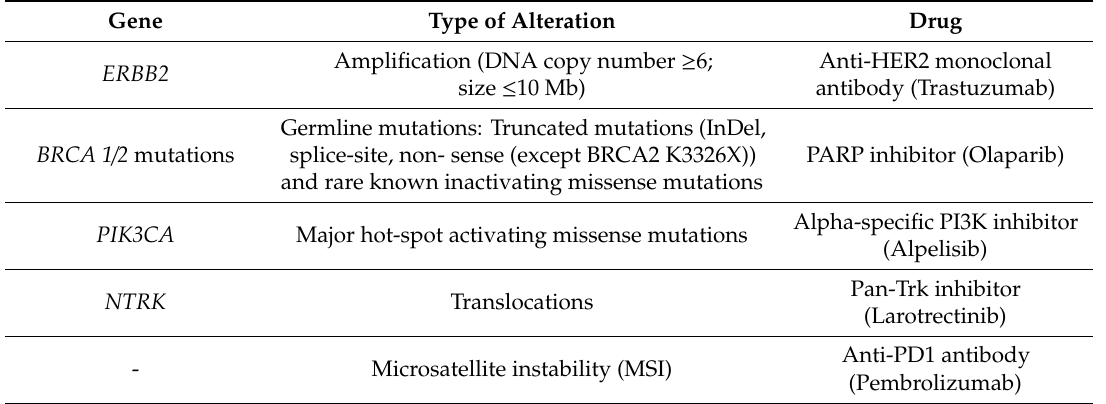
Table 1. List of alterations ranked as level 1 by Condorelli et al.